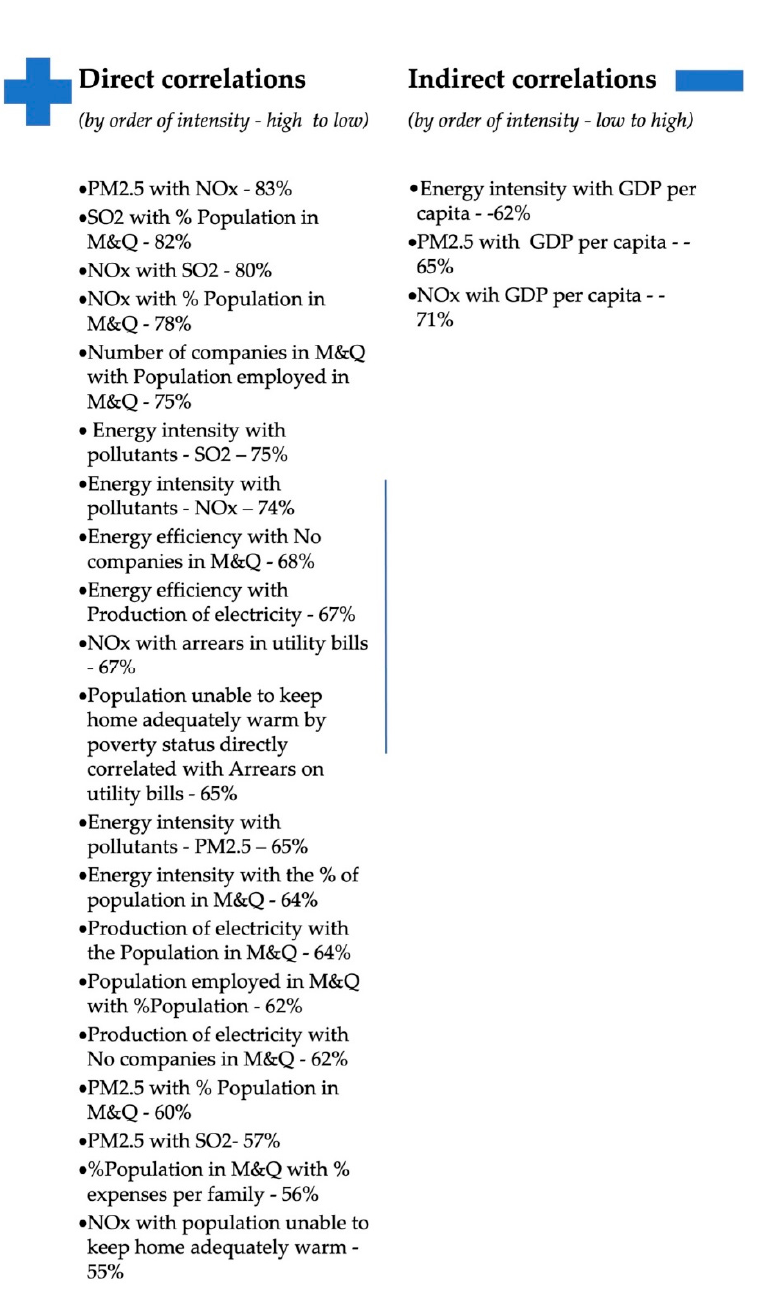
Figure 5. Results of the correlations between relevant Just Transition Indicators for Romania—in preparation of the cluster